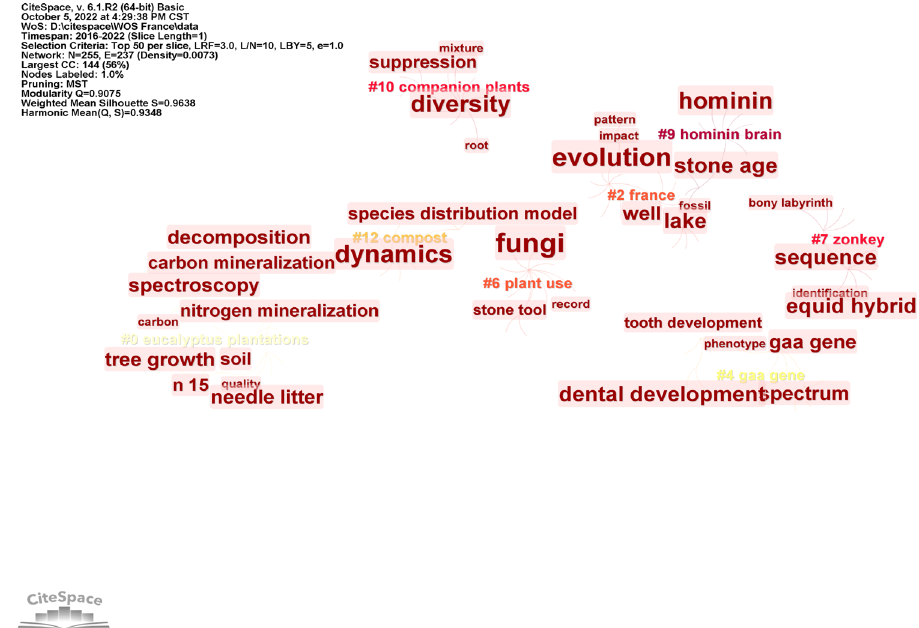
Fig. 4 Keywords and knowledge clusters of Rhine-Marne Canal of France literatures in WoS database (2003 –